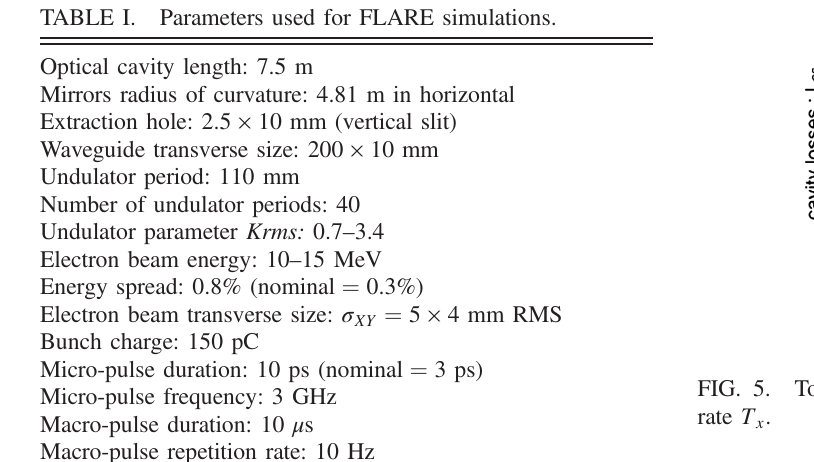
of the cavity versus the extraction os